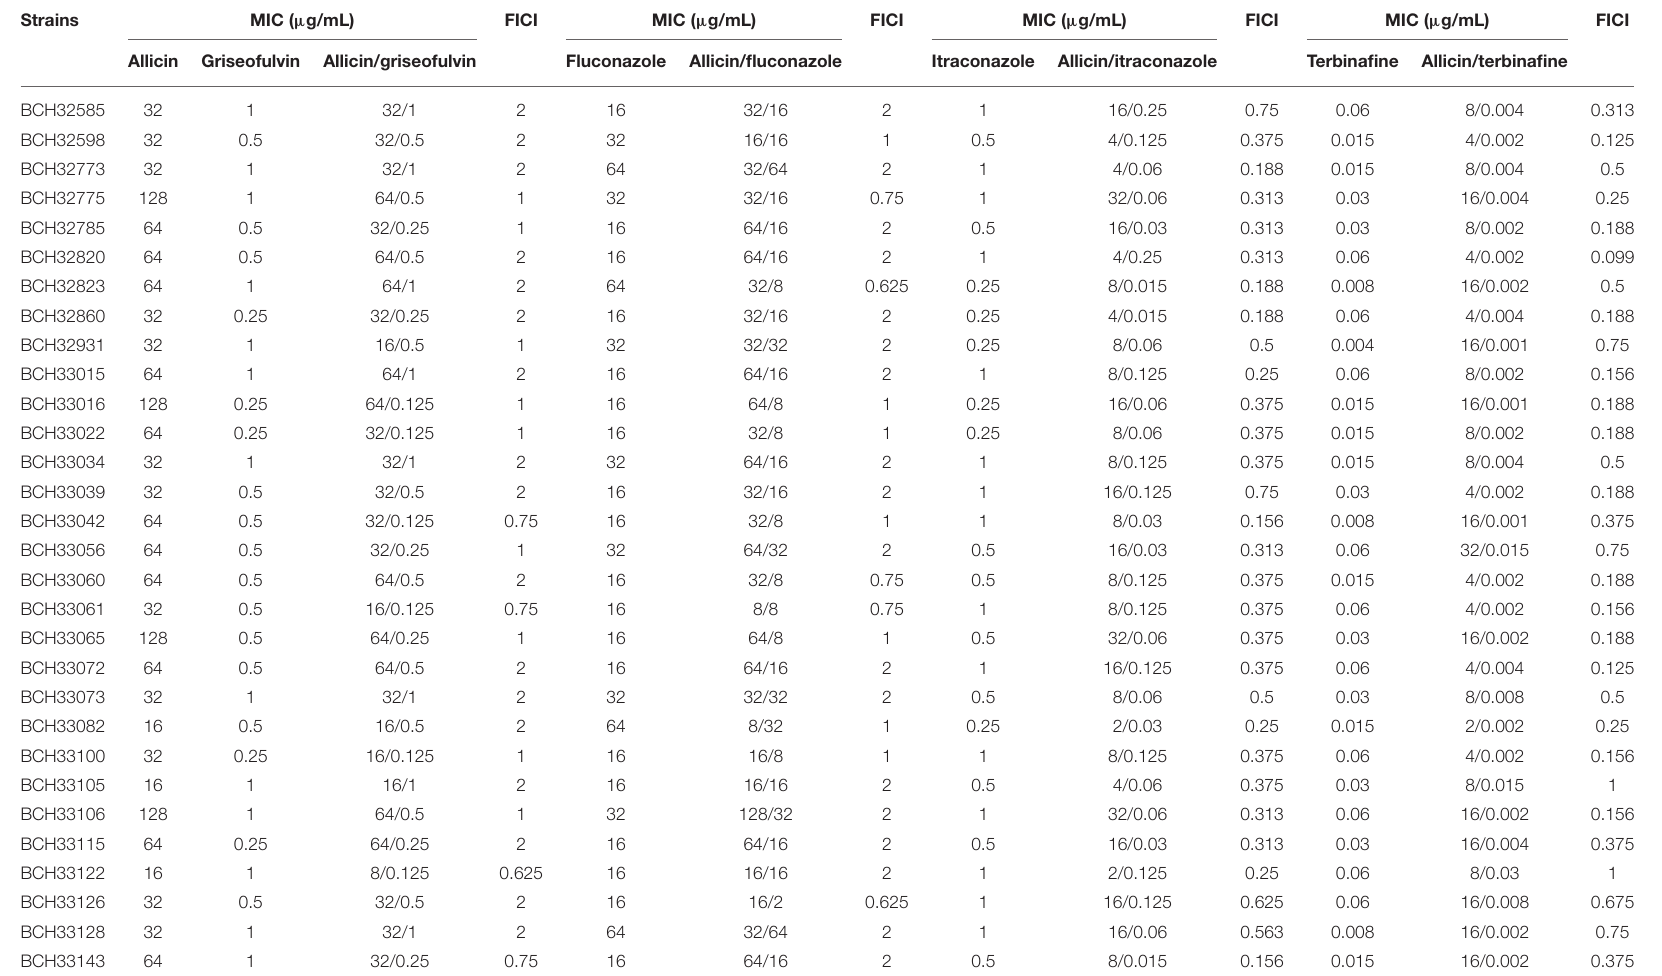
TABLE 1 | In vitro interactions of allicin with griseofulvin, fluconazole, itraconazole, and terbinafine against M. canis